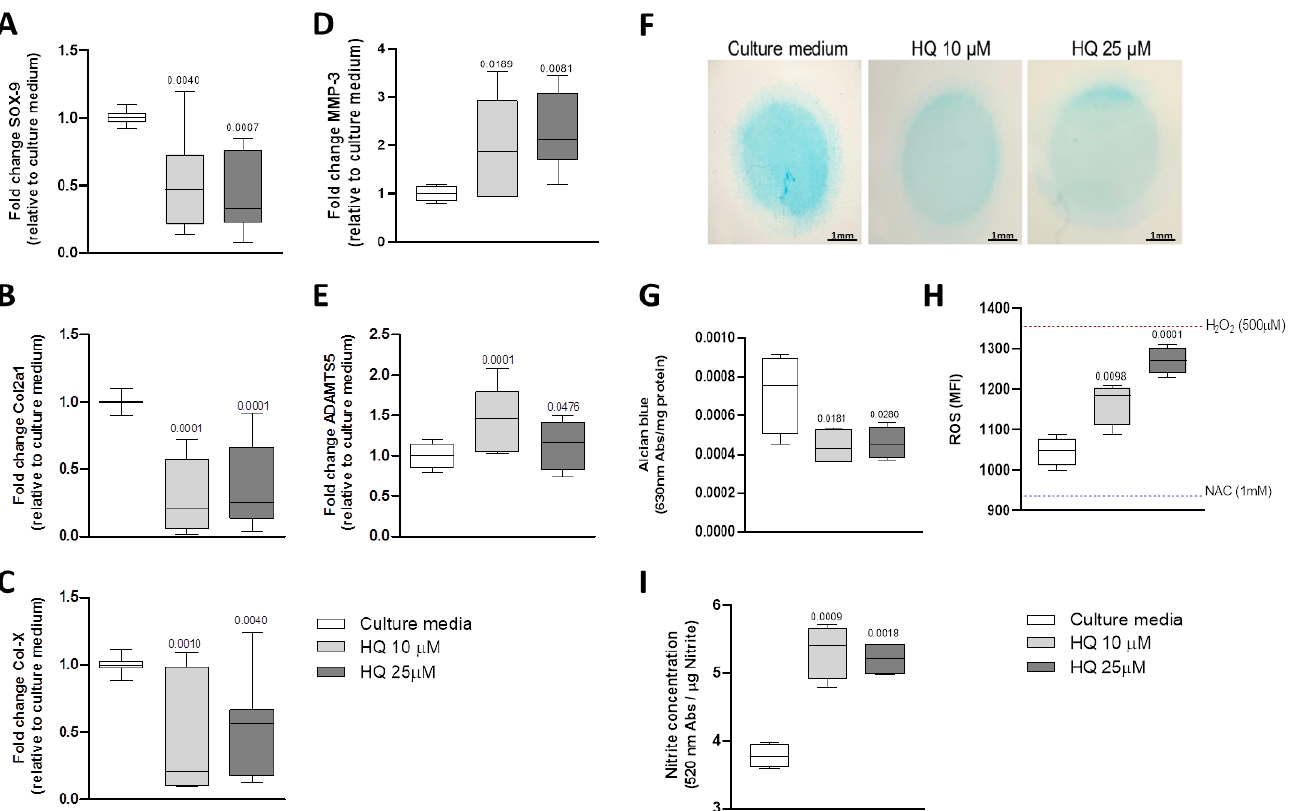
Figure 3. HQ exposure modulates the expression of phenotypic markers in articular chondrocytes. HQ stimulation of monolayer cultures of BACs downregulated the phenotypic markers SOX-9 ( A ), Col2a1 ( B ), and Col-X ( C ) but upregulated the catabolic enzymes MMP-3 ( D ) and ADAMTS5 ( E ). HQ exposure reduced the production of highly sulphated GAGs ( F , G ) over 48 h incubation on BACs in micromass cultures, as measured by Alcian Blue quantification. HQ also increased ROS generation ( H ), quantified by DCFH-DA assay and nitrite production ( I ), quantified by Griess reaction in micromass cultures. qPCR results were normalised to the housekeeping gene β -actin and expressed as fold change in comparison to culture media. MFI = median of fluorescence intensity. Data represent mean ± SEM from three independent experiments and were analysed with one-way ANOVA.